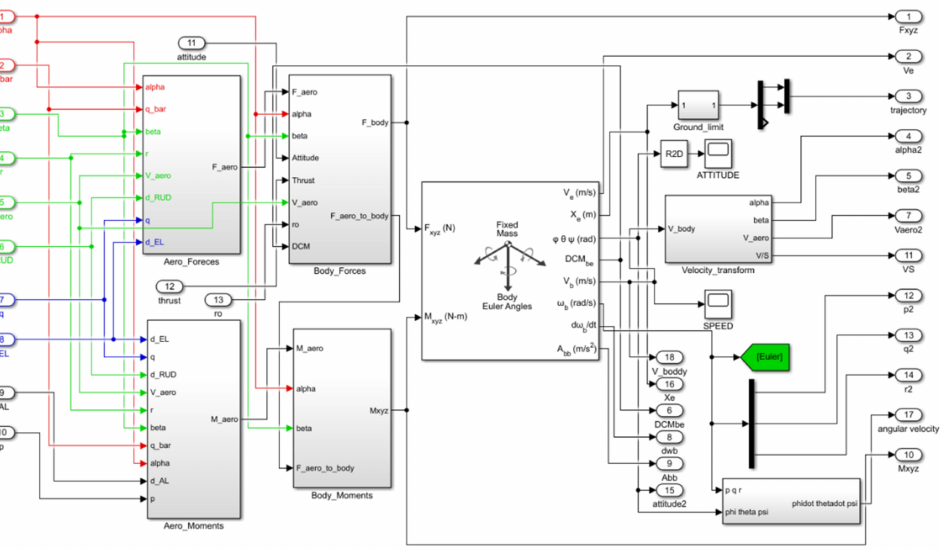
Figure 8. Mathematical simulation 6DoF model of the dynamic movement of the “SkyDog” UAV. To verify it, a comparison was made in the longitudinal plane. During the comparison, the angle of longitudinal inclination of the aircraft θ was observed in a few seconds because the deviation of the simulated data from the measured ones increases with time. This phenomenon is since the model does not include forces acting on the aircraft during